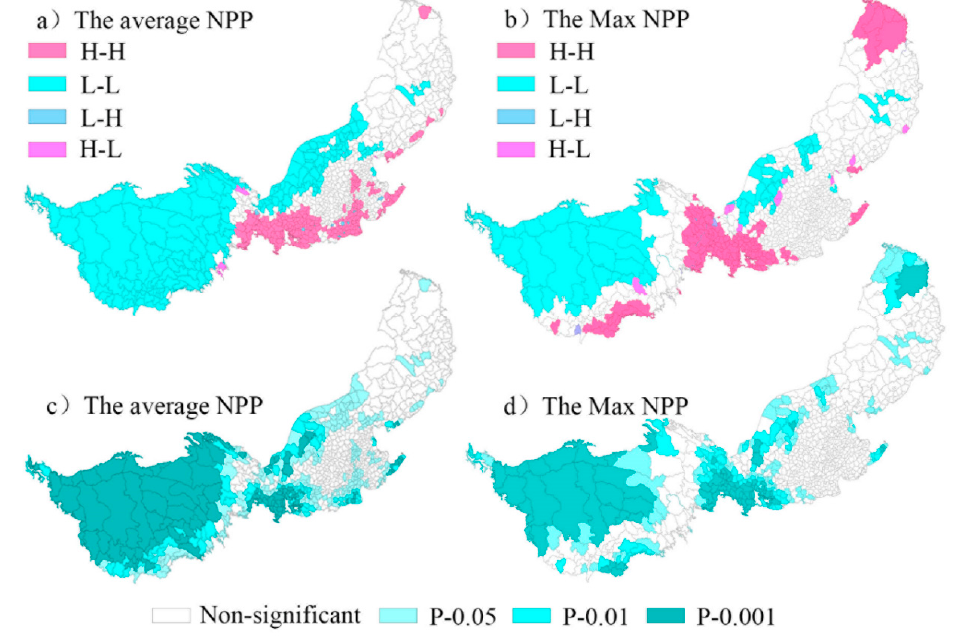
Figure 3. Local spatial agglomeration ( a , b ) and significance ( c , d ) of average and Max NPP values.